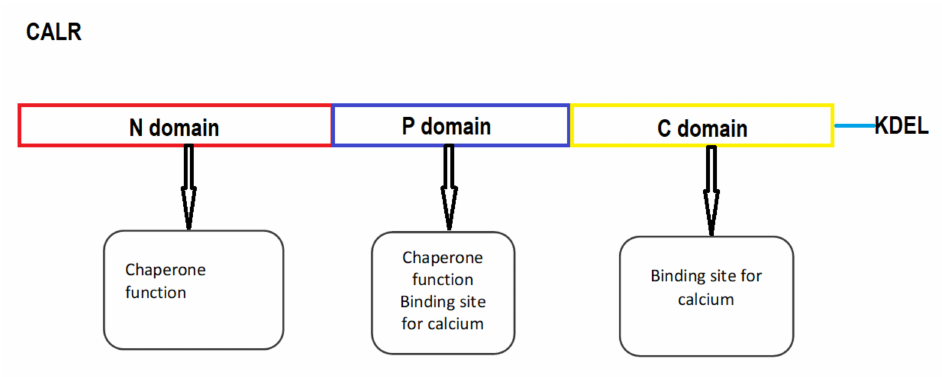
Figure 1. The schematic structure of CALR. KDEL, endoplasmic reticulum-retention